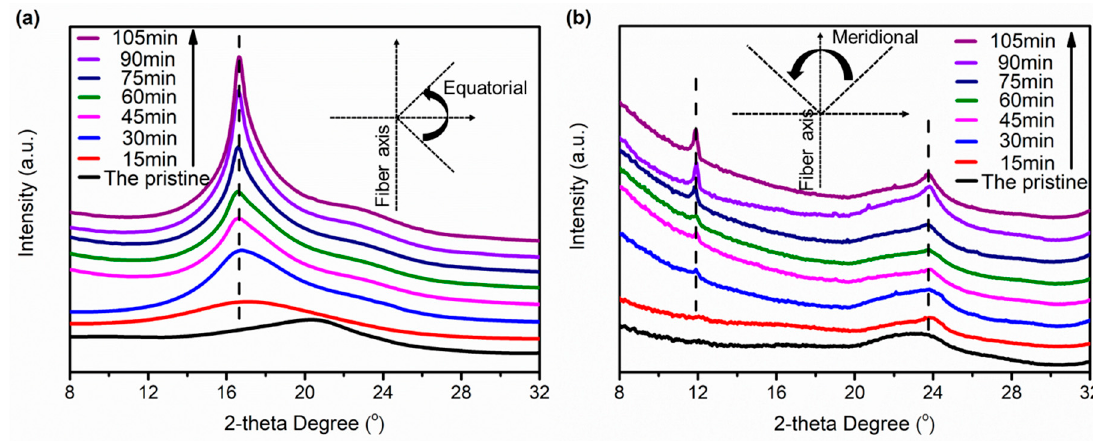
Figure 7. The integral diffraction intensities of wide angle X-ray scattering patterns of the pristine and treated F-III fibers in Sc-CO 2 : ( a ) equatorial direction, ( b ) meridional direction.